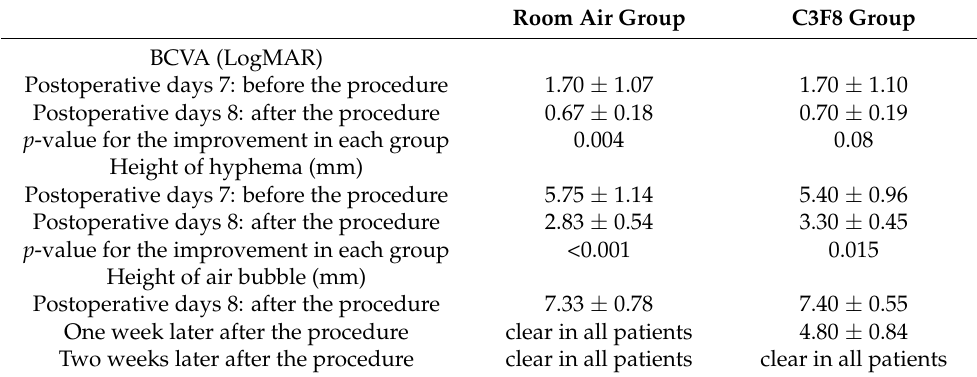
Table 2. Visual and anatomical outcomes in the room air and perfluoropropane